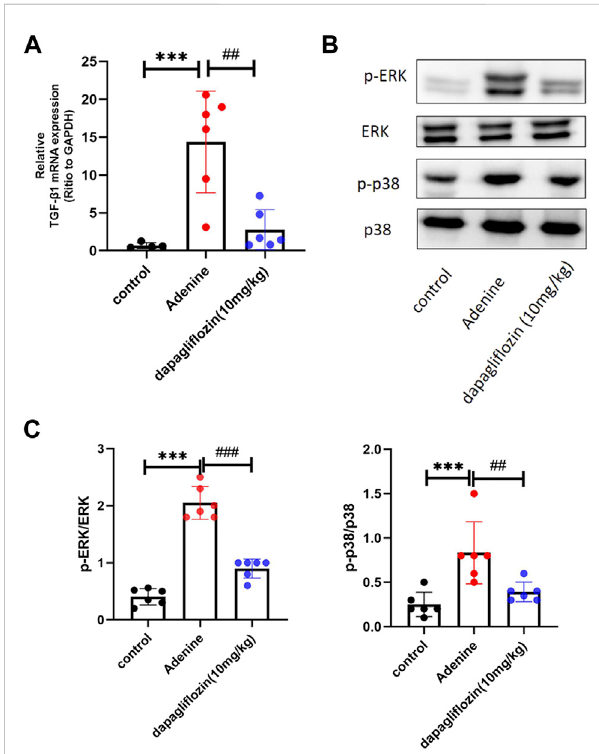
FIGURE 5 Dapagli fl ozin alleviated in fl ammation and increased antioxidant proteins in0.2% adeninediet-fed mice. (A) Realtime PCR showingthe expression of IL-1 β , IL-6, TNF- α , cxcl-1, and mcp-1 in the renal tissue in each group. (B) The activity of SOD and content of GSH in the renal tissue of each group. (C) The content of MDA in the renal tissue of each group. Values are means ± SD. ** p < 0.01 adenine diet group compared with the control group; *** p < 0.001 adenine diet group compared with the control group; ## p < 0.01 dapagli fl ozin treatment group compared with the adenine diet group; ### p < 0.001 dapagli fl ozin treatment group compared with the adenine diet